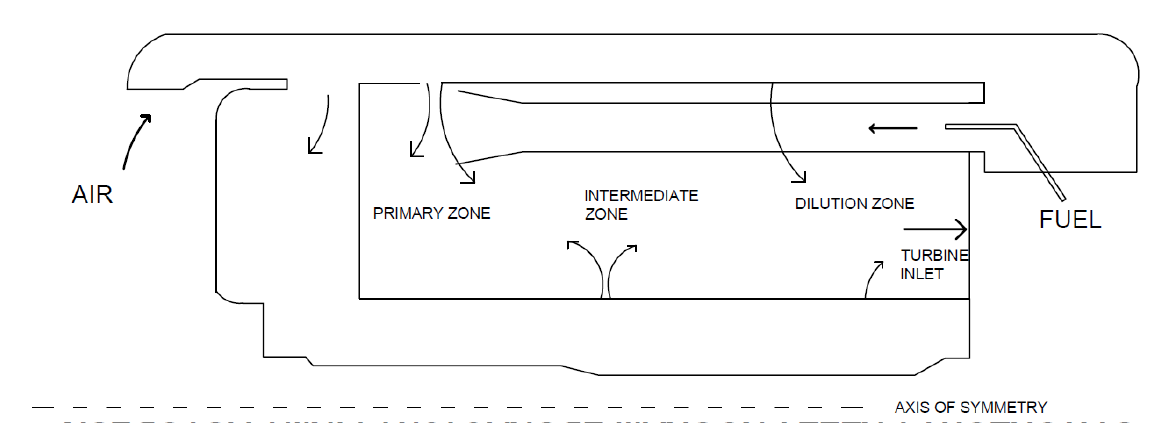
Figure 2: Annular combustor with reverse-flow vaporizer.